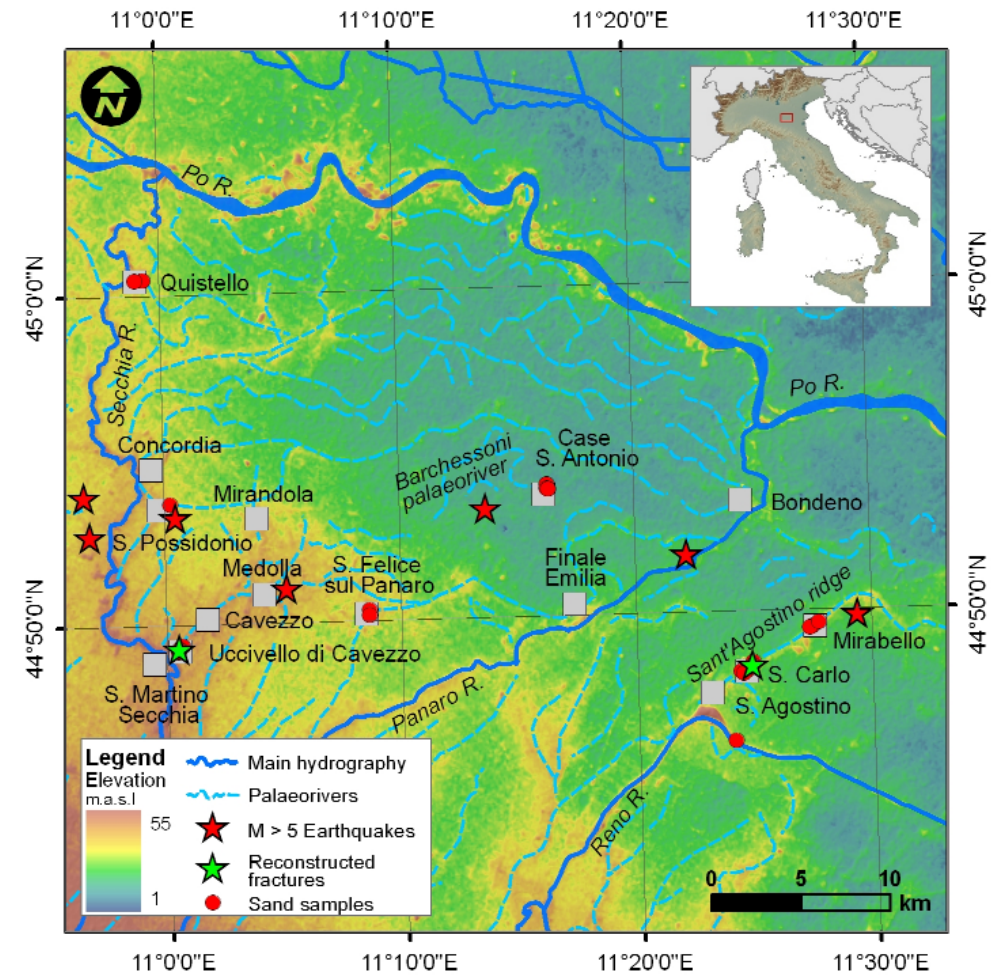
Figure 1. Shuttle Radar Topography Mission (SRTM; cell size, ca. 90 m), red dots represent the location of sand samples. It should be noted that most of the samples came from areas located on high fluvial